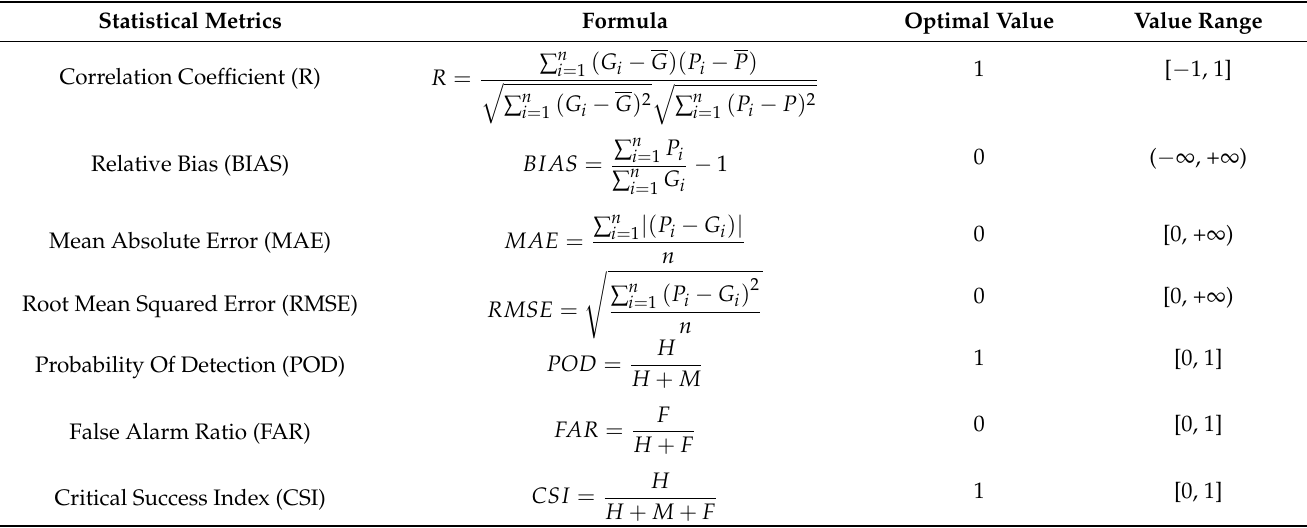
Table 1. The statistical index of SPPs